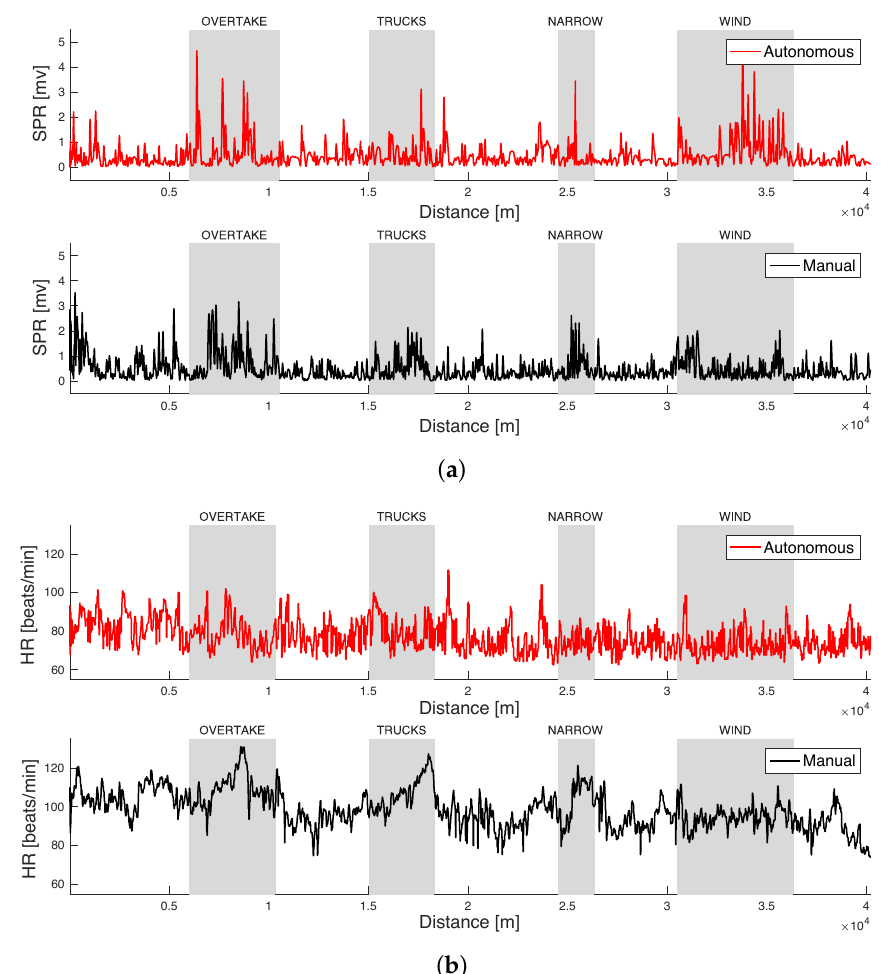
Figure 6. ( a ) The Skin Potential Response (SPR) signal (local RMS value), after the application of the MA removal algorithm, in both driving scenarios. ( b ) The Heart Rate (HR) signal in both driving scenarios. The four areas, corresponding to the stress episodes, are also